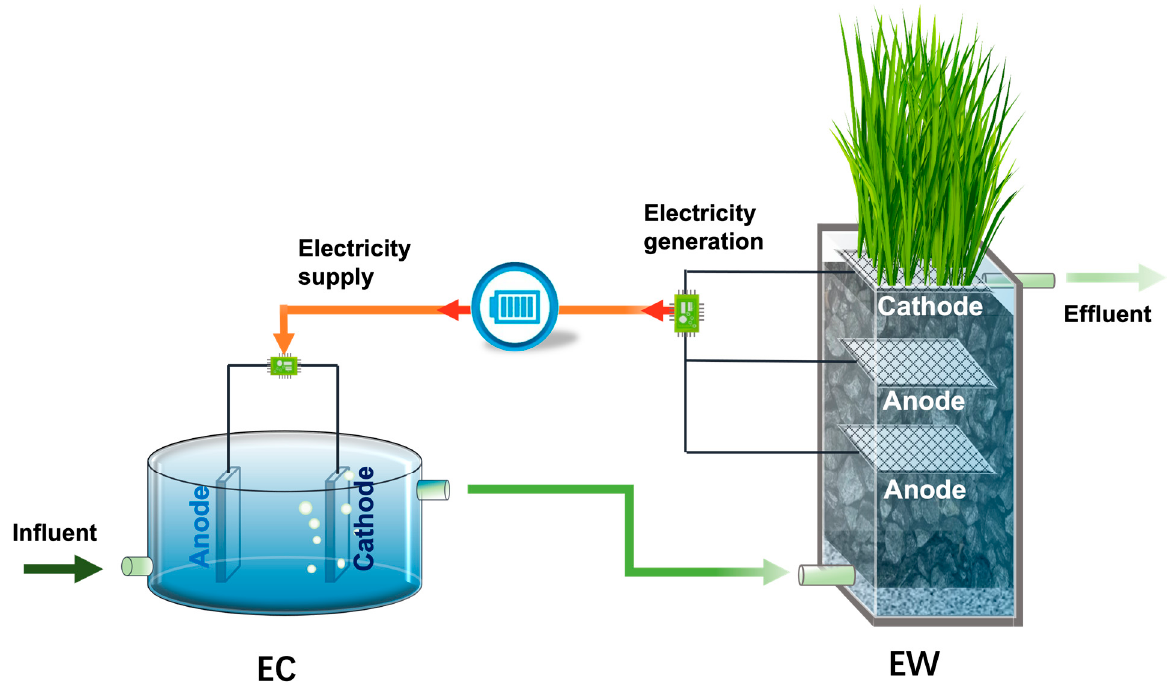
Figure 6. Schematic diagram of the EC powered by EW. EC applies the micro-electrical current to remove contaminants in an aqueous environ- ment and therefore presents the best possibility to use the power generated from EW